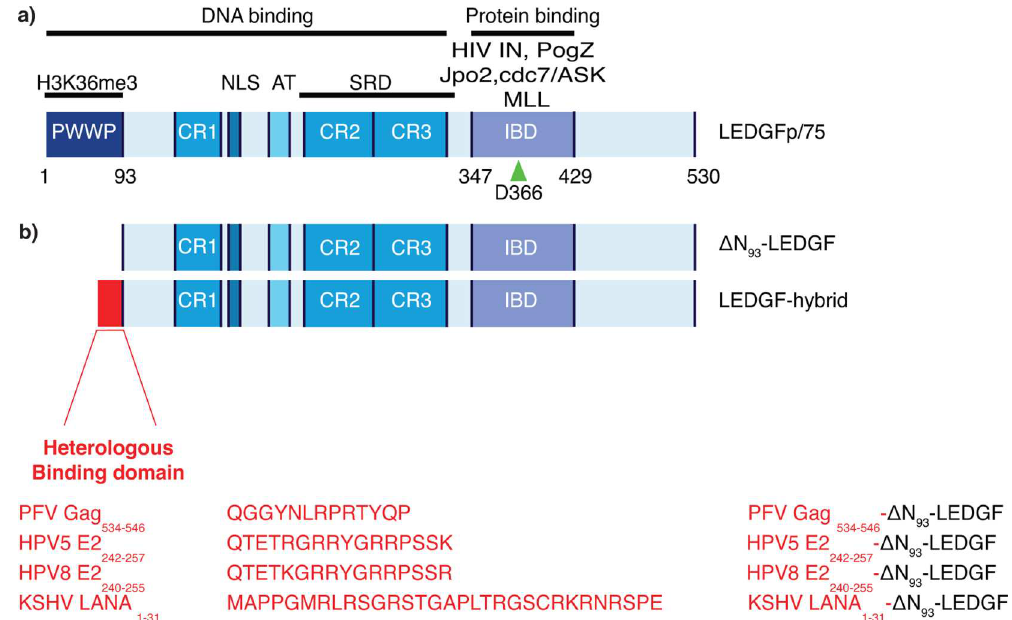
Fig 1. Schematic representation of the LEDGF/p75 domain structure and artificial LEDGF-hybrids. (a) LEDGF/p75 contains a C-terminal protein-binding domain, coined Integrase BindingDomain (IBD) responsible for HIV-IN interaction. Several endogenous proteins like Jpo2, PogZ and MLL bind to the same interface. At its N- terminal end carries multiple chromatin interacting domains, the PWWP domain, the AT hook-likedomain(AT) and three charged regions (CR1, 2, 3). D366 is a pivotal amino acid involvedin HIV-IN interaction (arrowhead). Mutation to Asn (D366N) abolishesHIV-IN interaction. The lower panel (b) depicts the different LEDGF-hybrids, PFV Gag 534-546 - Δ N 93 -LEDGF, HPV5 E2 242-257 - Δ N 93 -LEDGF, HPV8 E2 240-255 - Δ N 93 -LEDGF and LANA 1-31 - Δ N 93 - LEDGF respectively. Numbers indicate the different amino acid residues. AT, AT-Hook; CR, Charged Region; SRD, Supercoiled Recognition Domein; IBD, Integrase BindingDomain; PWWP, Pro-Trp-Trp-Pro Domain; PFV, Prototype foamy virus; LANA, Latency associated nuclear antigen; HPV, Human papillomavirus; LEDGF, Lens epithelium-derived growth factor; NLS, Nuclear localizationsignal.